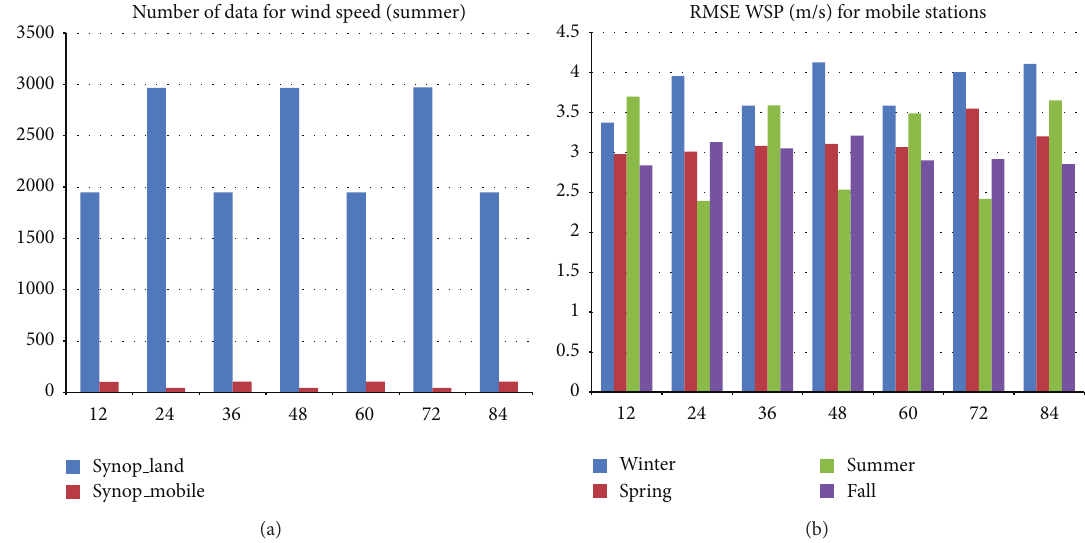
Figure 9: (a) Number of data available for land and mobile SYNOP stations, (b) as in Figure 5(b) for mobile SYNOP stations.